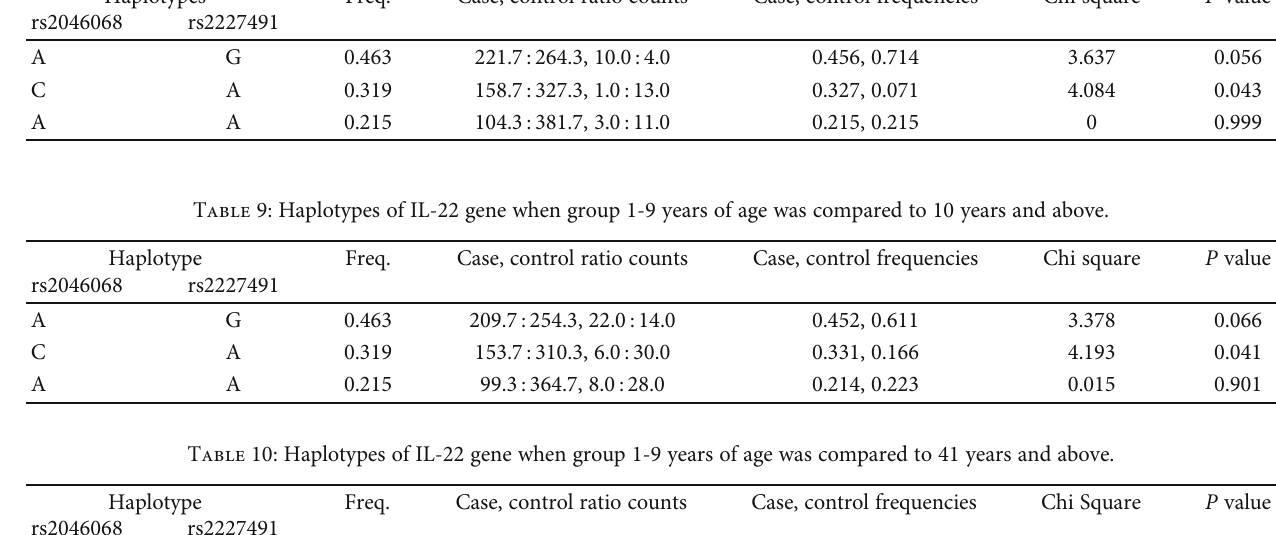
Table 8: Haplotypes of IL-22 gene when group 1-5 years of age was compared to 6 years and above. Haplotypes Freq.